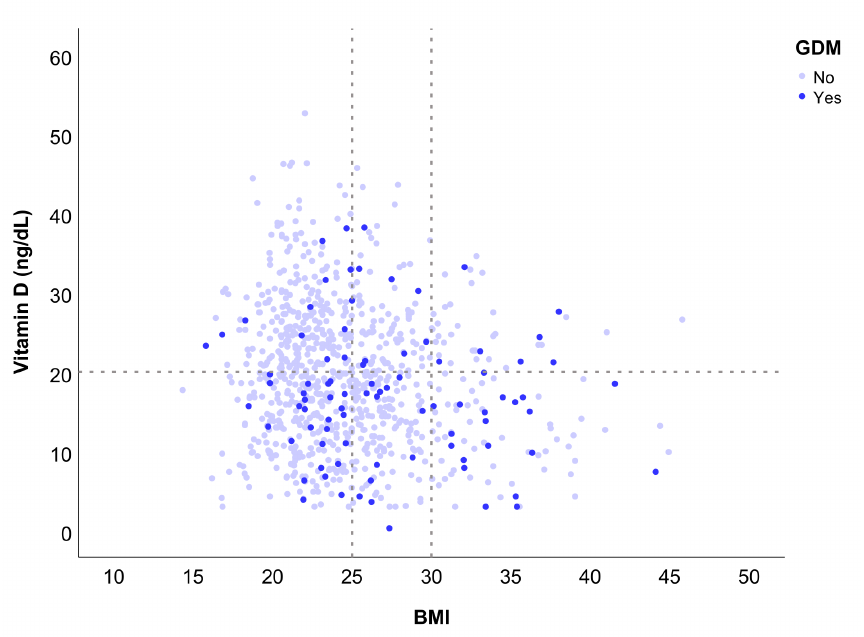
Figure 1. Individual vitamin D serum level distribution across the entire sample, in relation to BMI and GDM (the horizontal dotted line represents the threshold for VDD as <20 ng/dL, while the vertical dotted lines represent the limits of the BMI groups: Normal weight <25, overweight 25–30, and obesity